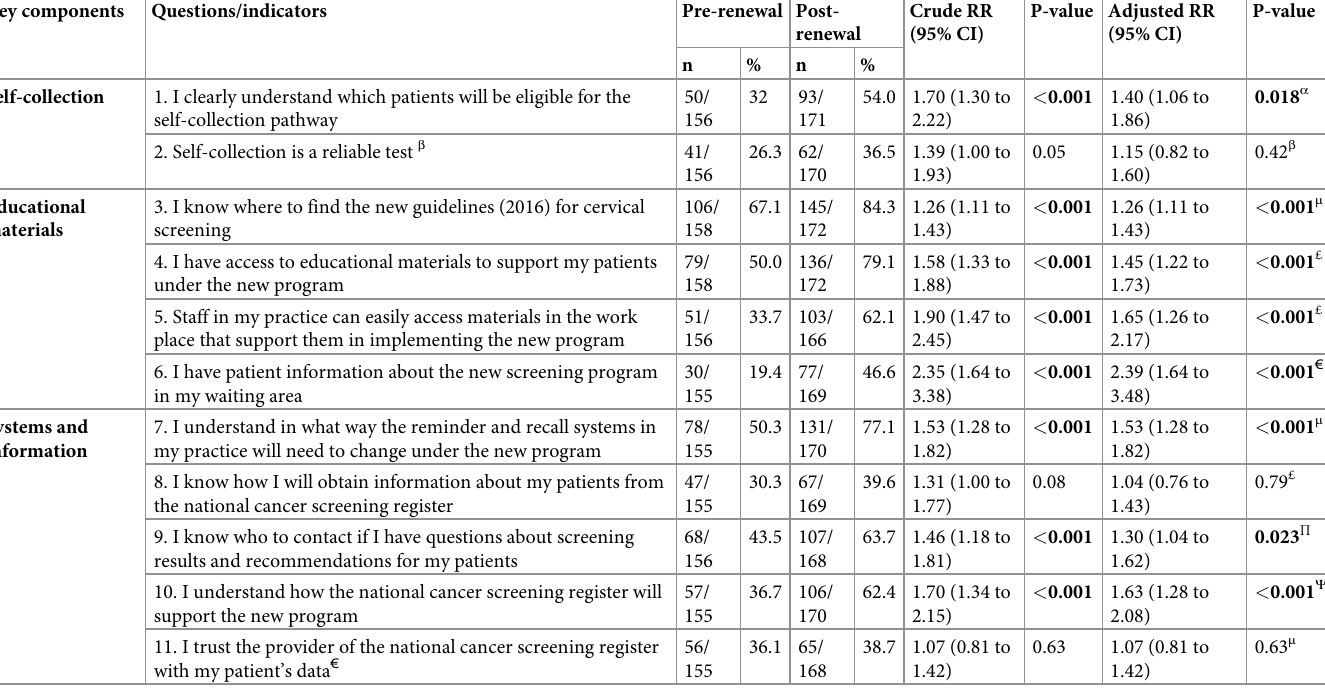
Table 5. Practitioners’ reporting about access to resources and systems to support the transition of the cervical screening program in the pre- and post-renewal samples � . Key